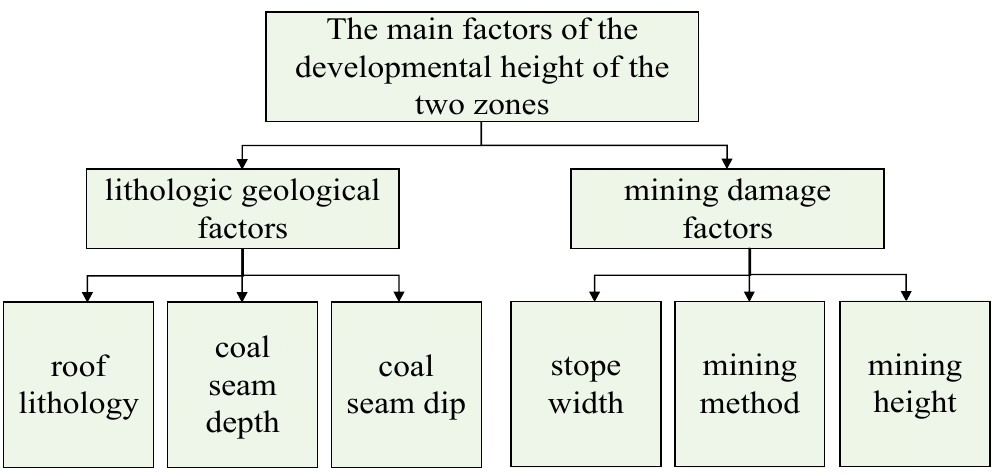
Figure 4. Factors affecting the height of the water-conducting fracture.